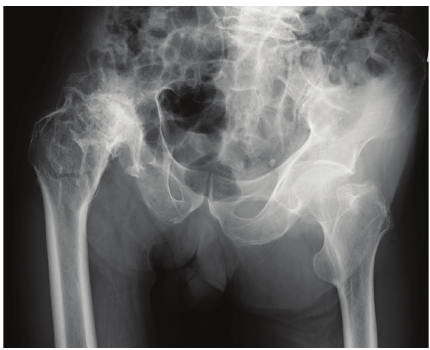
Figure 1: Anteroposterior radiograph showing an intertrochanteric fracture of the right hip joint that was ankylosed because of arthrodesis performed 56 years earlier.